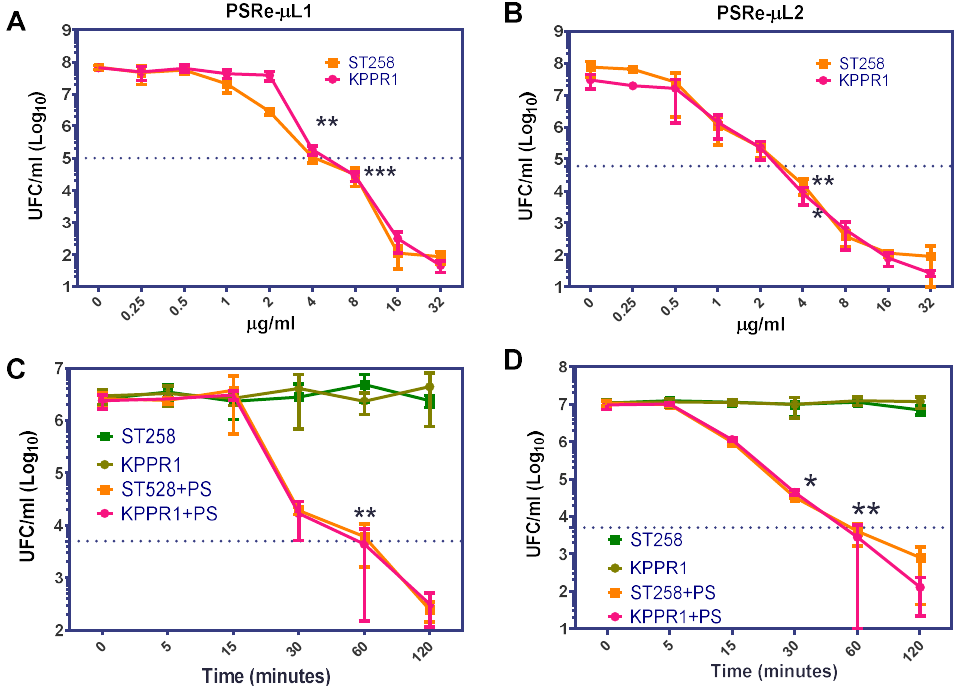
Figure 3. Determination of minimum effective concentration and time lethality. The minimum effective concentration (MEC) and lethality of the PSRe-µL1 and PSRe-µL2 were determined using the imipenem-sensitive (KPPR1) and the imipenem resistant (ST258) strains of K. pneumoniae . For MEC determination, bacteria at 1 × 10 7 CFU/mL were incubated with increasing concentrations (0–32 µg/mL) of the compounds PSRe-µL1 ( A ) or PSRe-µL2 ( B ) and exposed for 1 h to 17 µW/cm 2 of white LED light. The time lethality was determined, mixing the bacteria with 4 µg/mL of PSRe-µL1 ( C ) or PSRe-µL2 ( D ), and exposure for increasing times (5, 15, 30, 60, and 120 min) to 17 µW/cm 2 of white LED light. Colony count enumerated viable bacteria on ca-MH agar after serial-microdilution. The CFU/mL values are presented as means ± SD on a log 10 scale (* p < 0.05, ** p < 0.01, *** p < 0.001 by Student’s t -test among bacteria treated with PS exposed to light compared to untreated control